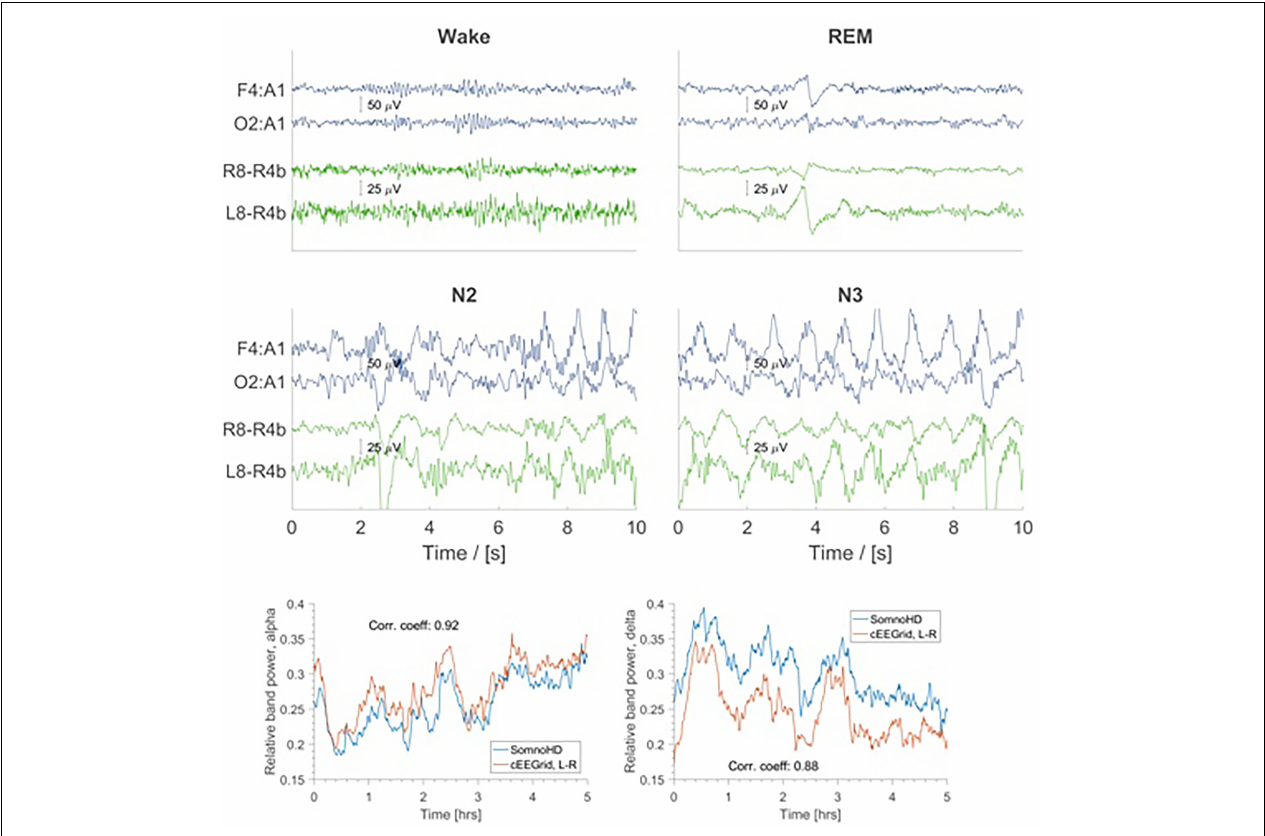
FIGURE 4 | Top four panels: EEG traces for SomnoHD (blue) and cEEGrid (green). Bottom panel: Average relative power in the alpha (8–16 Hz) and delta (1–4 Hz) frequency bands depicted for SomnoHD and cEEGrid. Not all subjects had 5 h worth of NREM recording, meaning that the number of subjects included in the average decreases with